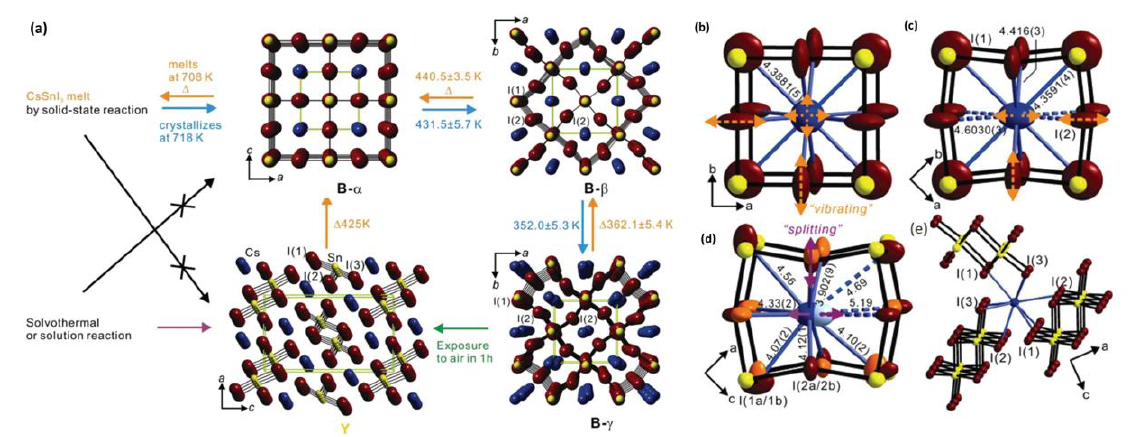
Figure 2. ( a ) Phase transition diagrams of four CsSnI 3 polycrystalline types; coordination environ- ment of Cs atoms at different temperatures in the black phase ( b ) 500K (B−α), ( c ) 380K (B−β), and ( d ) 300K (B−γ); ( e ) coordination environment of Cs atoms in the yellow phase (Y) [43].